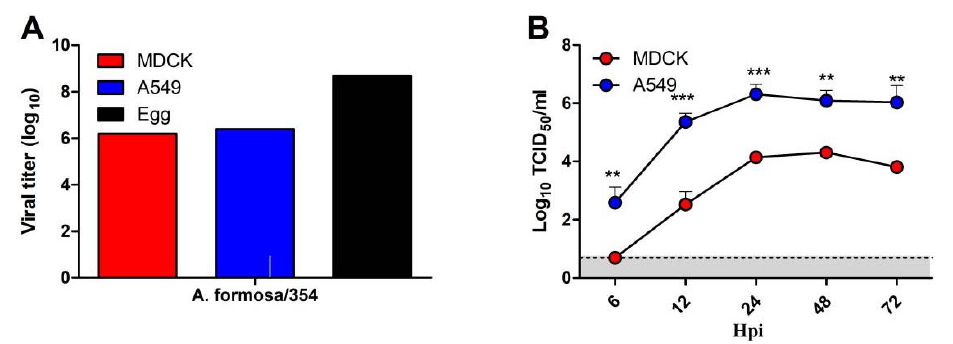
Figure 5. Viral titers and growth kinetics of H12 virus. ( A ) H12 virus was titrated in MDCK, A549 cells,